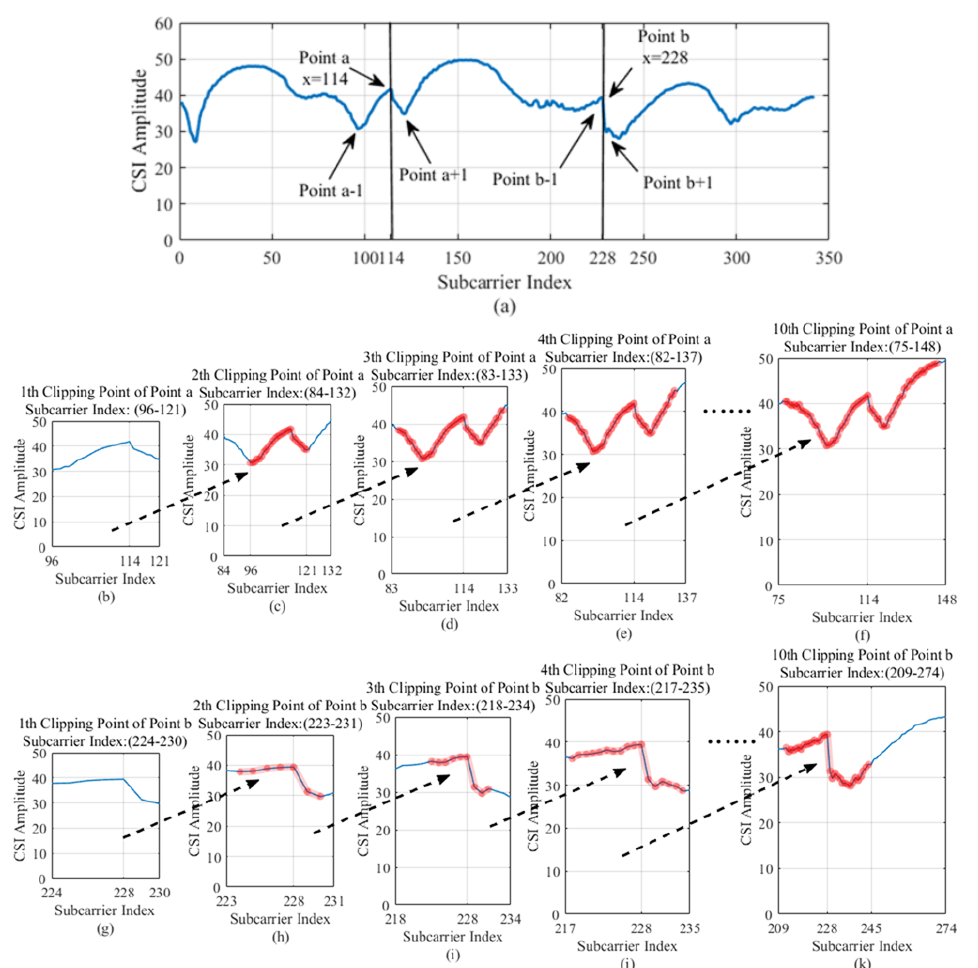
Figure 5. Characteristics of CSI amplitude extract. ( a ) Representation of the two clipping base points of a and b of the fusion link. ( b , g ) CSI amplitude characteristics obtained from the first clipping point. ( c , h ) CSI amplitude characteristics obtained from the second clipping point. ( d , i ) CSI amplitude characteristics obtained from the third clipping point. ( e , j ) CSI amplitude characteristics obtained from the forth clipping point. ( f , k ) CSI amplitude characteristics obtained from the tenth clipping